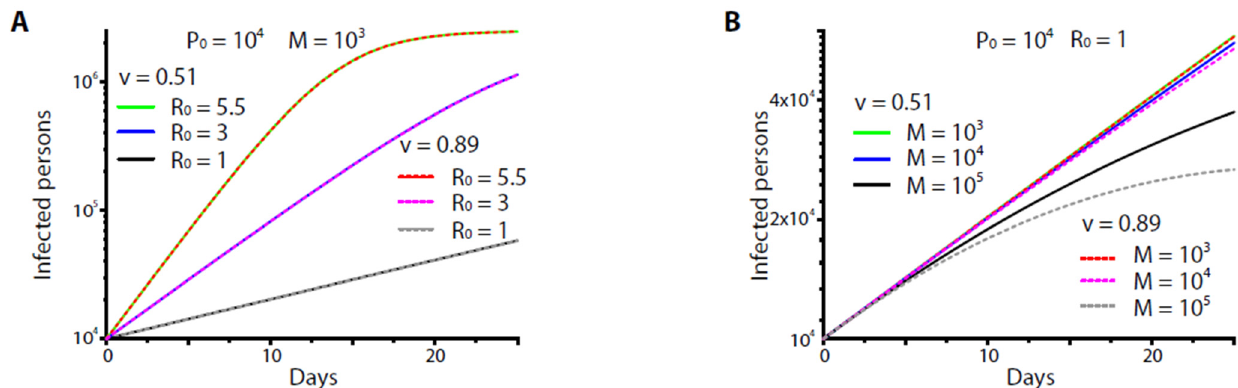
Figure 2. The numerical results from Equation (5) when ( A ) 10 3 fully vaccinated persons were yielded per day at various R 0 , and when ( B ) various fully vaccinated persons ( M ) were yielded per day at R 0 = 1. For ( A ), note that there was almost no difference in the results between the two vaccines and that a significant reduction of infected persons occurred at R 0 = 1 (black and grey lines) For ( B ), note that curves at M = 10 3 –10 4 persons/day were almost overlapped regardless of the vaccine effectiveness. A reduction of the infected persons occurred only when M = 10 5 persons/day (black and grey lines). For all the results, the average infectious period T i was set as 14 days, the initial carrier number P 0 = 10 4 , and the number of entire population N = 2.5 × 10 6 . v = 0.51 or 0.89 was the effectiveness of the vaccine.